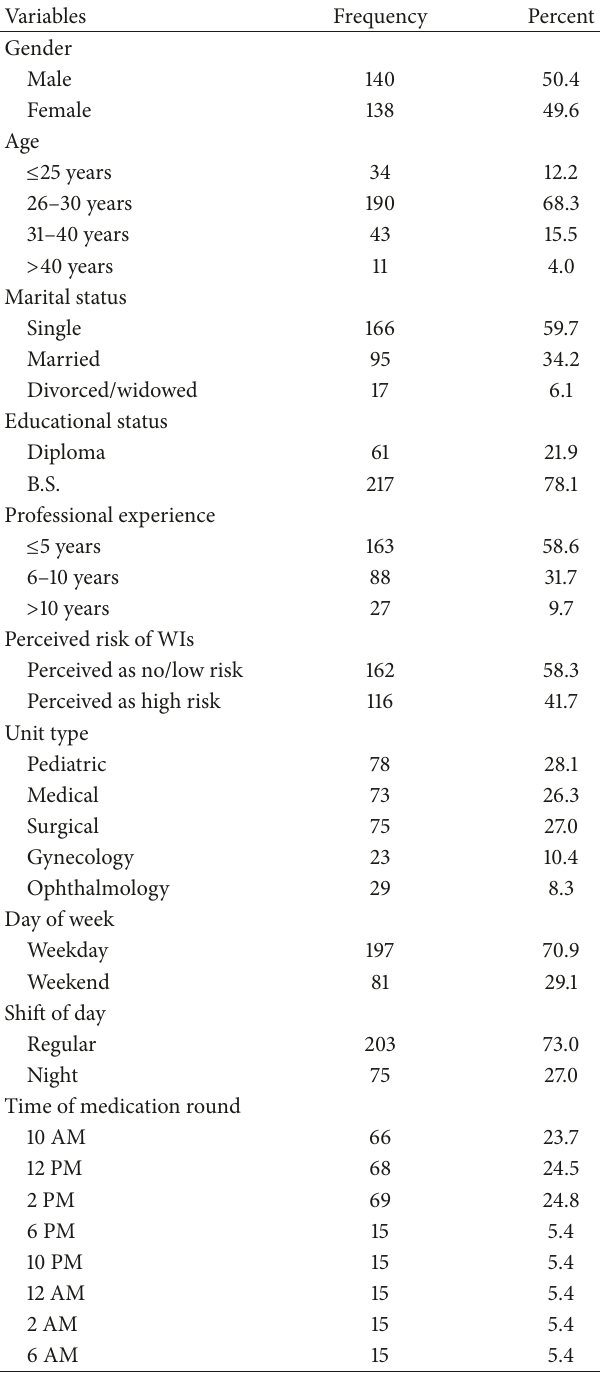
Table 1: Sociodemographics, work environment, and perceptual characteristics of